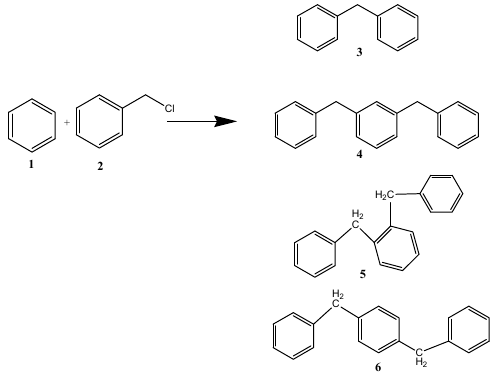
Scheme 1. Reaction scheme for benzylation of benzene.